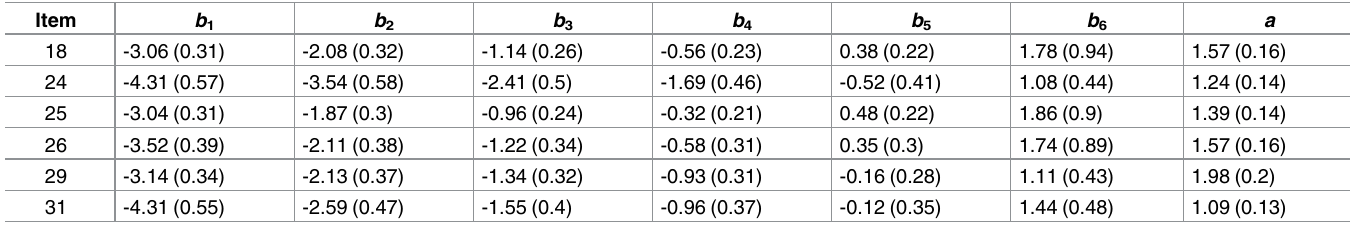
Table 6. Intellectual humility–Engagement item parameter